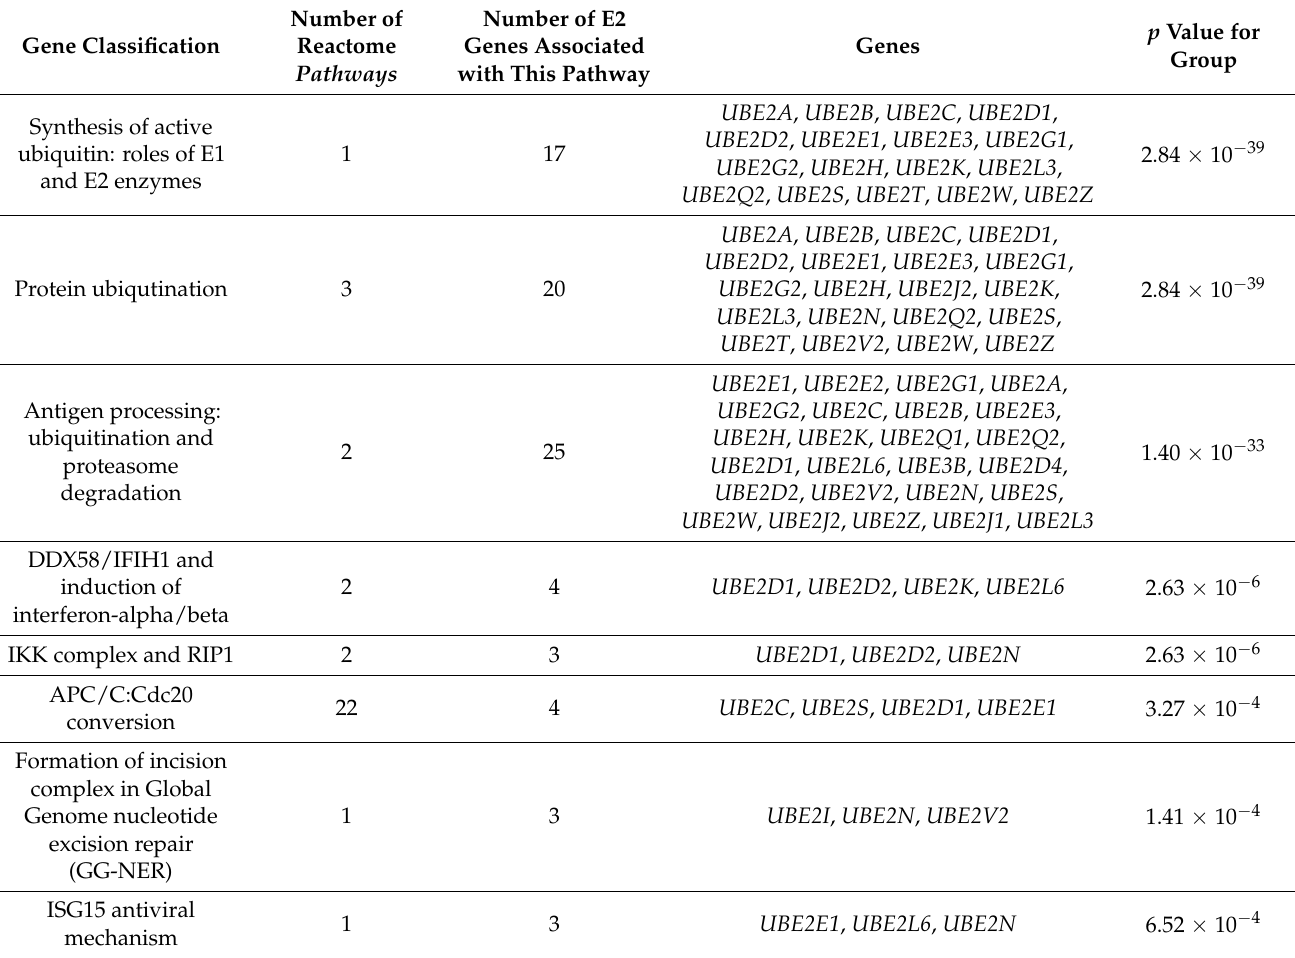
Table 2. Reactome Pathways * associated with differentially expressed genes encoding for E2